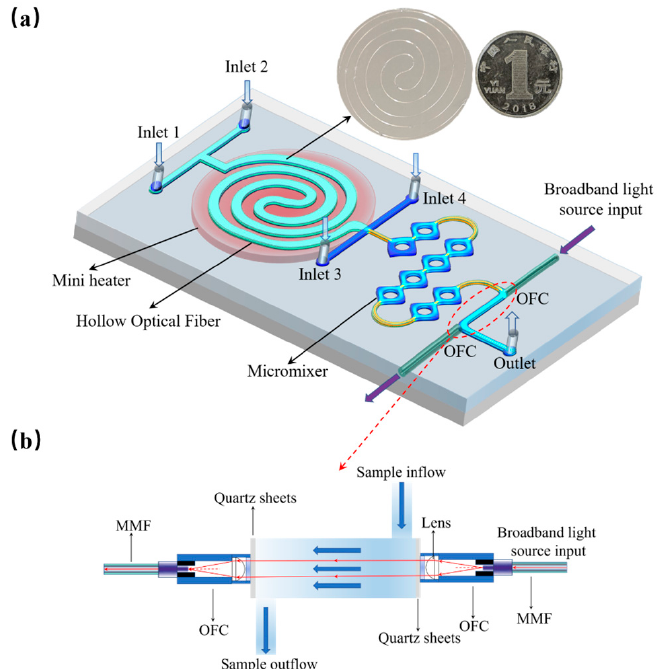
Figure 1. Design of the integrated optofluidic device: ( a ) 3D schematic of the device. The inner diameter of the hollow optical fiber for digestion is 100 µm and the height of mixer is 150 µm; ( b ) the design and cross section of the part for optical detection. The lens of the optical fiber collimator has a focal length of 10 mm, and a wavelength range of 650–1050 nm. The spot size of the spot of the output light is about 0.6 mm, and its numerical aperture (NA) of the multimode optical fiber (MMF) is 0.22 (chrome-plated brass fiber with core diameter of 200 µm).